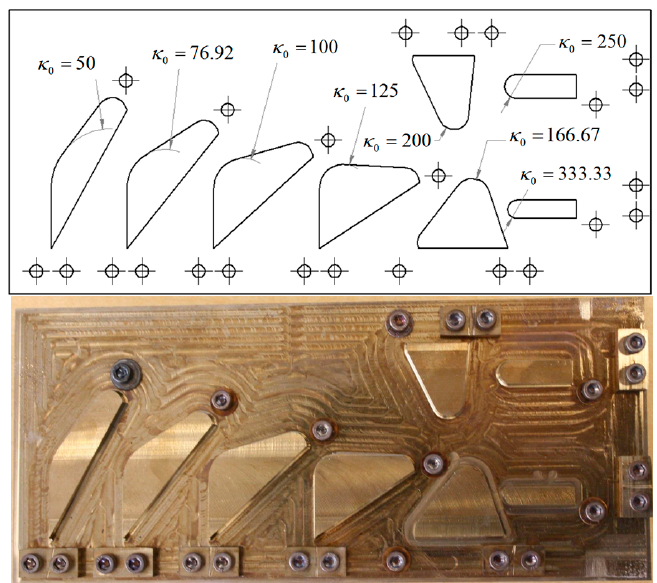
Figure 8. Custom fixture used for shape-setting SMA specimens: top—dimensioned drawing; bottom—photograph of machined fixture.